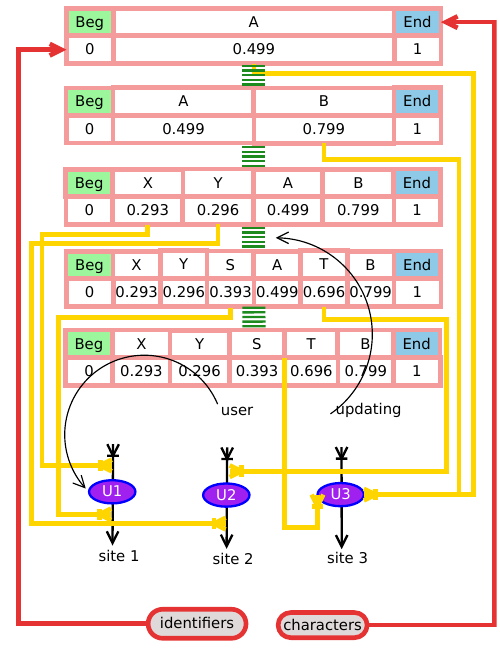
Figure 3. Multipleusers are in